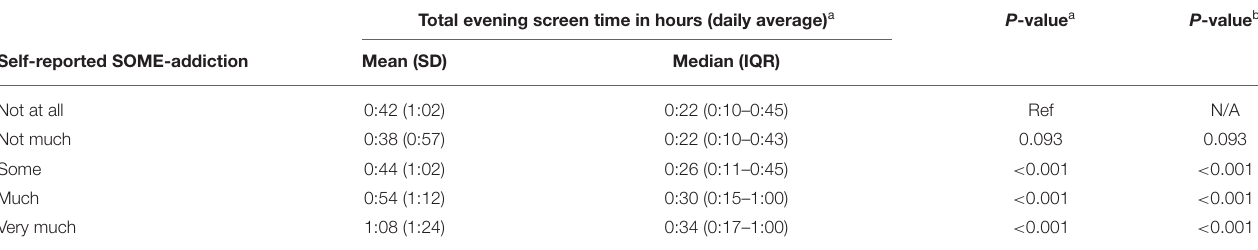
TABLE 3 | Mean, standard deviation, and median of total evening screen time in hours (daily average) across levels of self-reported social media addiction. Total evening screen time in hours (daily average) a P -value a P -value